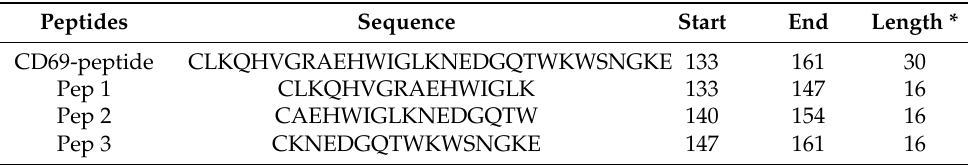
Table 1. The peptides synthesized in the